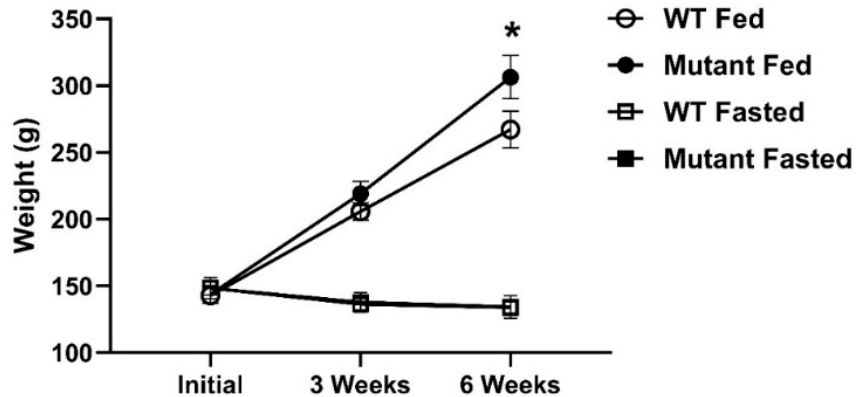
Figure 2. Body weight (g) over time from WT and LepR mutant rainbow trout that were fed to satiation or fasted for six weeks. Black and white squares for fasted groups are superimposed as there were no differences in weight. * denotes significant difference between WT and mutant fed fish at six weeks ( p = 0.03, n = 12–15; initial and three week sampling n = 26–30). Growth, feed intake, and body morphometric responses for the fed LepR mutant and WT fish from the phenotyping study are shown in Figure 3. There was a significant main effect of genotype (WT vs. mutant) on feed intake (FI), condition factor (CF), specific growth rate (SGR), and HSI (Figure 3I), although pairwise comparisons between WT and LepR mutants within a time period were not always significantly different. LepR mutant fish exhibited greater FI (three weeks; p = 0.02; WT: 1.27 ± 0.07%, mutant: 1.47 ± 0.03%, and six weeks; p = 0.14; WT: 1.16 ± 0.04%, mutant: 1.27 ± 0.03%). The hyperphagia led to heavier body weight in mutants (three weeks; p = 0.30; WT: 205.69 ± 6.51 g, mutant: 219.16 ± 9.11 g, and six weeks; p = 0.03; WT: 267.17 ± 13.76 g, mutant: 306.41 ± 16.10 g), faster SGR (three weeks; p = 0.02; WT: 1.94 ± 0.14%, mutant: 2.27 ± 0.05%, and six weeks; p = 0.04; WT: 1.31 ± 0.02%, mutant: 1.57 ± 0.02%), and greater CF (three weeks; p = 0.08; WT: 1.48 ± 0.01%, mutant: 1.57 ± 0.04%, and six weeks; p = 0.004; WT: 1.44 ± 0.03%, mutant: 1.60 ± 0.03%). Mutant fish also displayed increases in VSI at three weeks ( p = 0.01; WT: 12.60 ± 0.26%, mutant: 14.18 ± 0.66%, and six weeks; p = 0.97; WT: 10.14 ± 0.27%, mutant: 10.16 ± 0.36%) and HSI at three weeks (there weeks; p = 0.03; WT: 2.32 ± 0.08%, mutant: 2.79 ± 0.18%, and six weeks; p = 0.31; WT: 2.16 ± 0.11%, mutant: 2.36 ± 0.17%). Fork length (cm) and feed conversion ratio (FCR) were similar between WT and LepR mutants (Figure